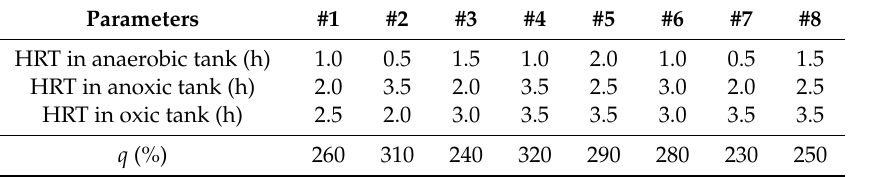
Table 4. Control strategies of the IRR optimization for #1, #2, ... , #8 AAO systems.